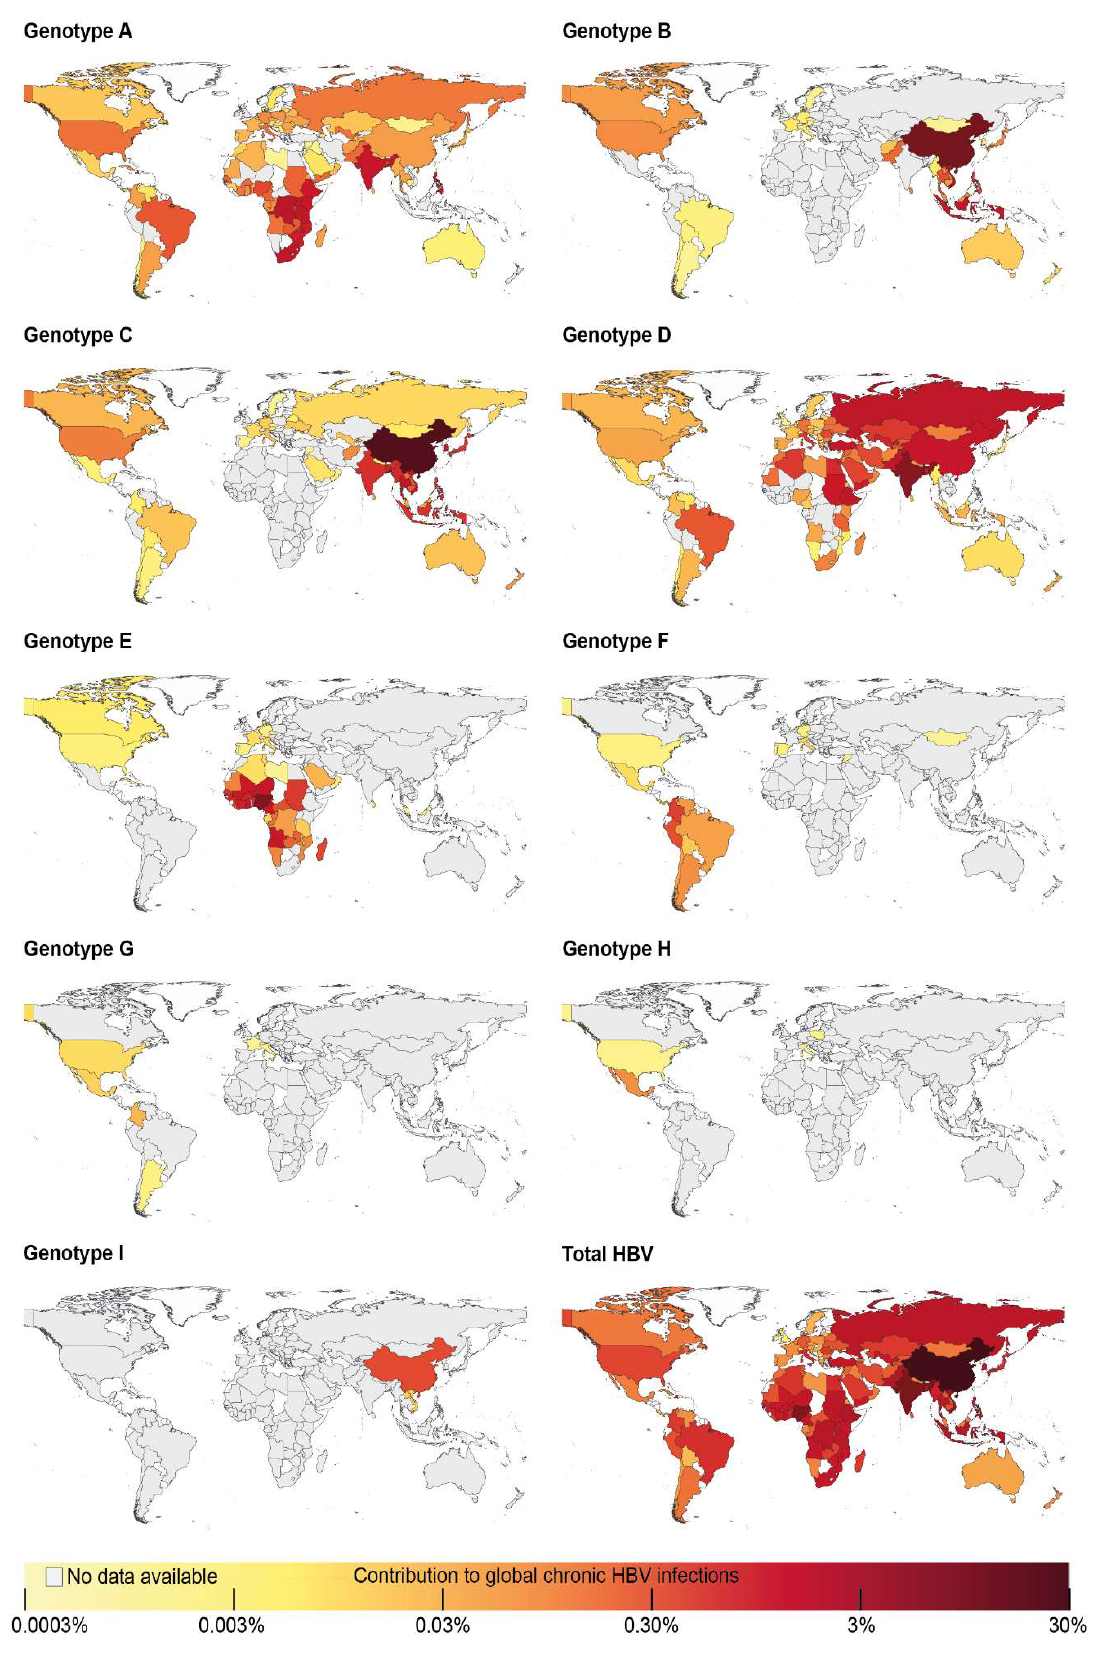
Figure 4. Contribution of genotypes to global chronic HBV infections. The number of infections with each genotype in a respective country is illustrated as percentage of global chronic HBV infections.